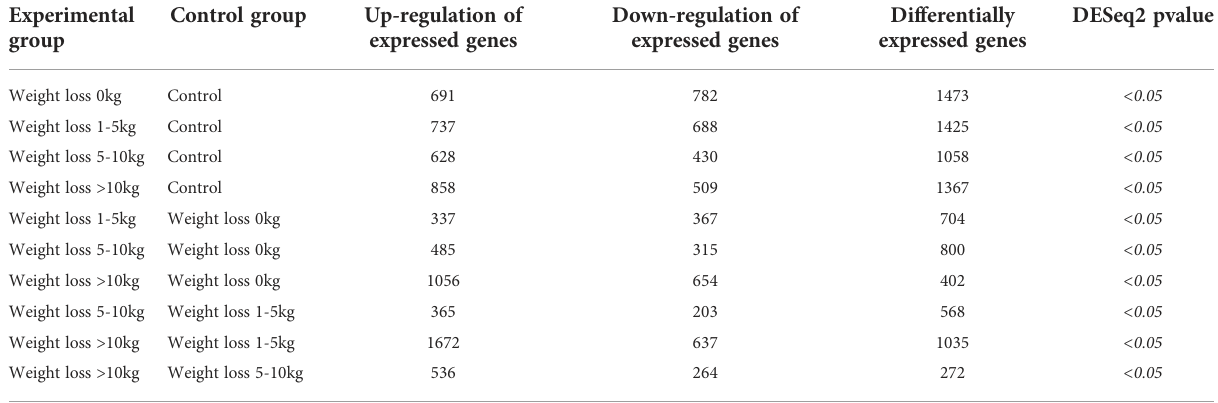
TABLE 8 Statistics of differential